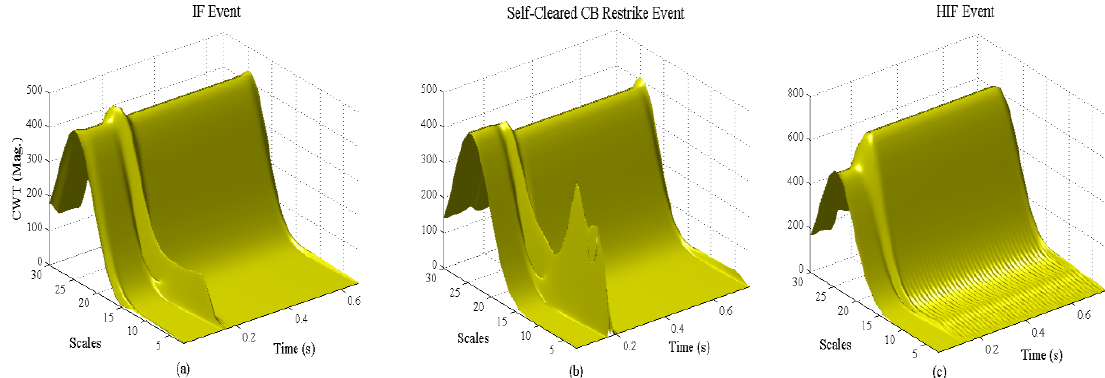
Figure 4. Different events show their effects on scales and time, ( a ) Incipient fault (IF); ( b ) Circuit breaker (CB) restrike during bank de-energization; ( c ) High impedance fault (HIF).